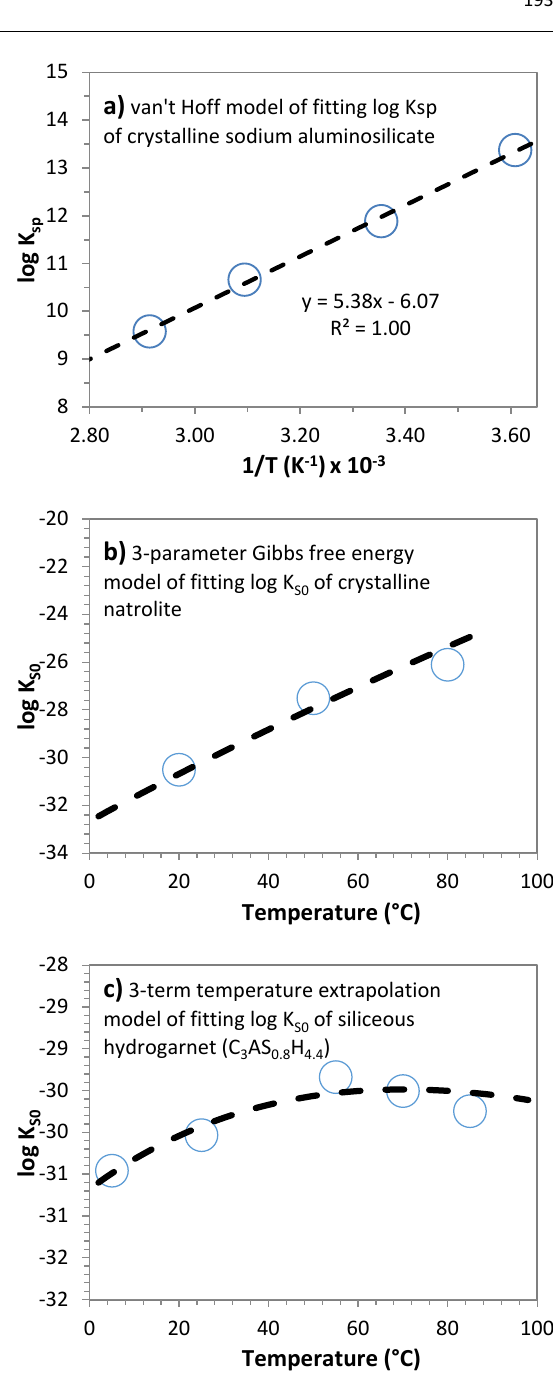
Figure 1. a) van’t Hoff model of fitting solubility data of crystalline N ‐ A ‐ S ‐ (H) (from Williamson et al., 2022) [74]; b) 3 ‐ parameter Gibbs free energy model of fitting solubility data of natrolite (from Lothenbach et al., 2017) [47]; and c) 3 ‐ term temperature extrapolation method of fitting solubility data of siliceous hydrogarnet (from Matschei et al. , 2007) [20]. The three ‐ parameter Gibbs free energy model fits calculated Gibbs free energy of formation values of the phase at different temperature according to Eq. 1 and 2 [47,70,75]. The experimentally ‐ determined solubility products of the dissolution reaction, 𝐾 (cid:3021) , at different temperature points can be used to calculate the Gibbs free energy of the